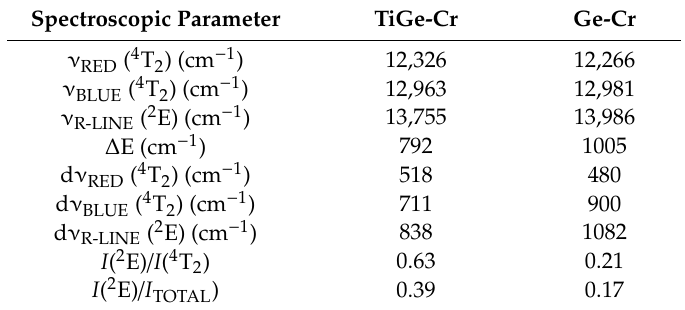
Table 1. Spectroscopic parameters for chromium ions in glasses TiGe-Cr and